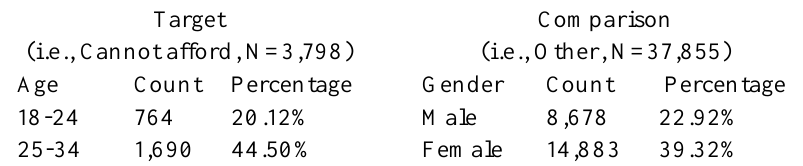
Age Breakdown for Learners in the Target vs. Comparison